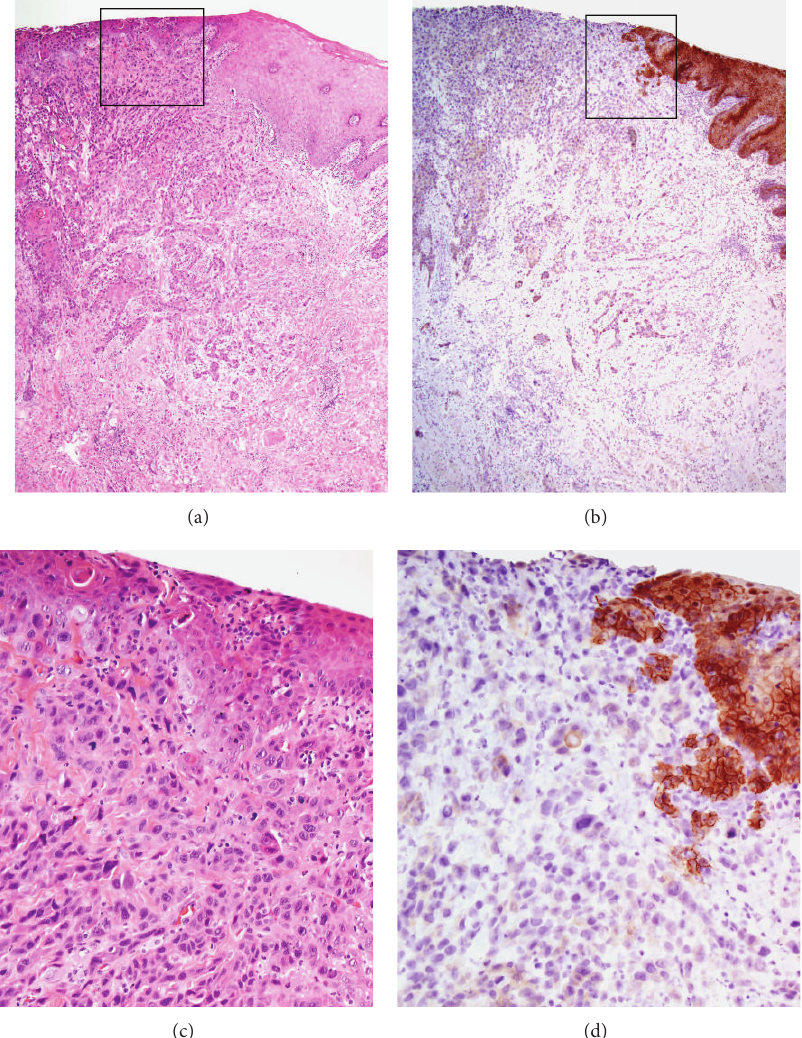
Figure 3: H&E (a) and CALML3 immunostained (b) sections of invasive squamous cell carcinoma with focal area of benign squamous mucosa under low power light microscopy (40x) and H&E (c) and CALML3 immunostained (d) sections of invasive squamous cell carcinoma with focal area of benign squamous mucosa under high power light microscopy (200x). Areas of invasive squamous cell carcinoma show a marked decrease in immunoreactivity ((b) and (d), left side of panels). Areas of intact benign oral mucosa maintain CALML3 expression with notable immunoreactivity (upper right in (c) and